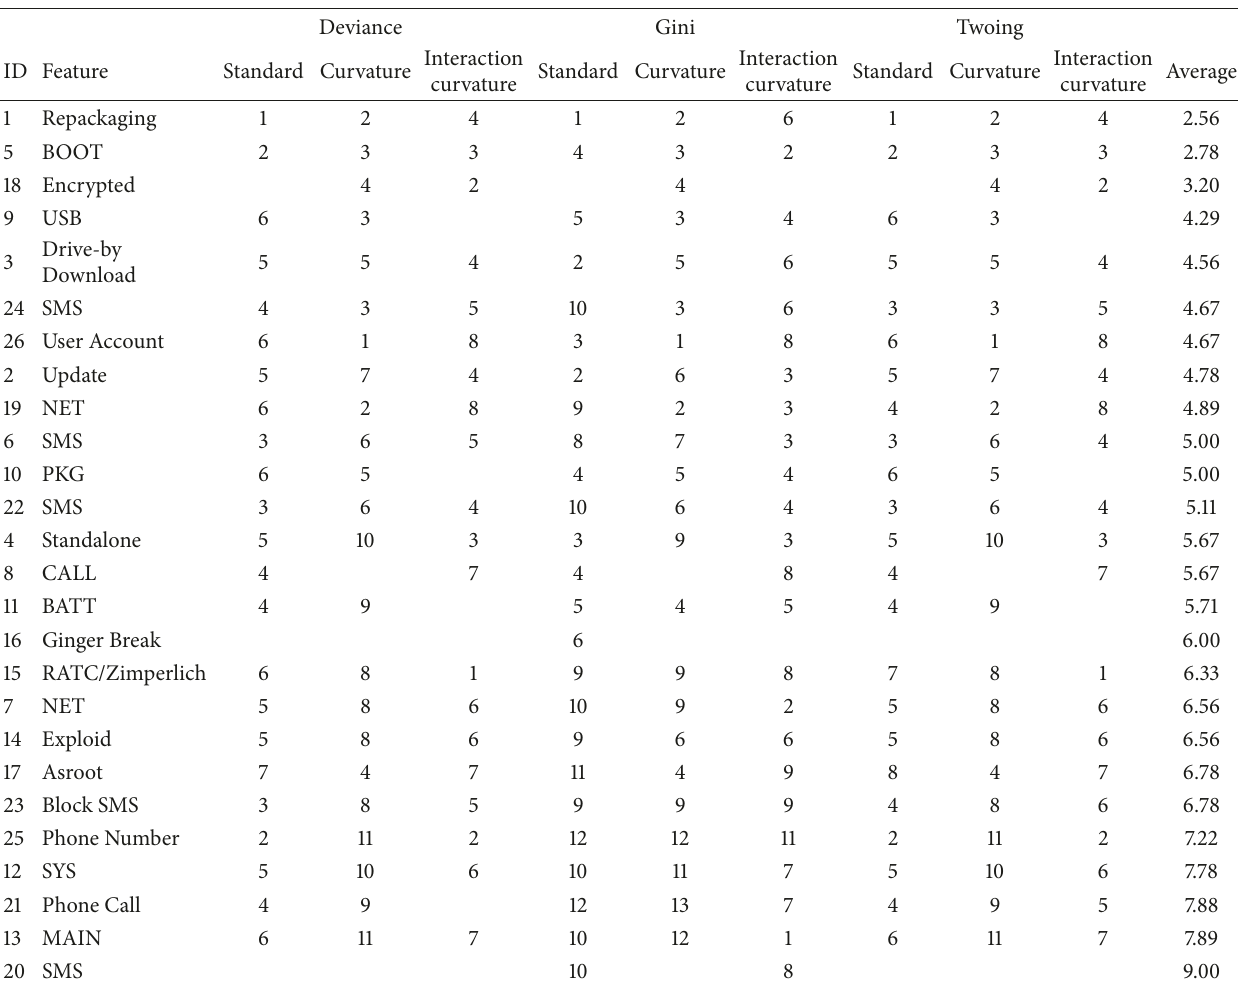
Table 2: Summary table of DT results: minimum depth of decision nodes for each one of the original features. Deviance Gini Twoing ID